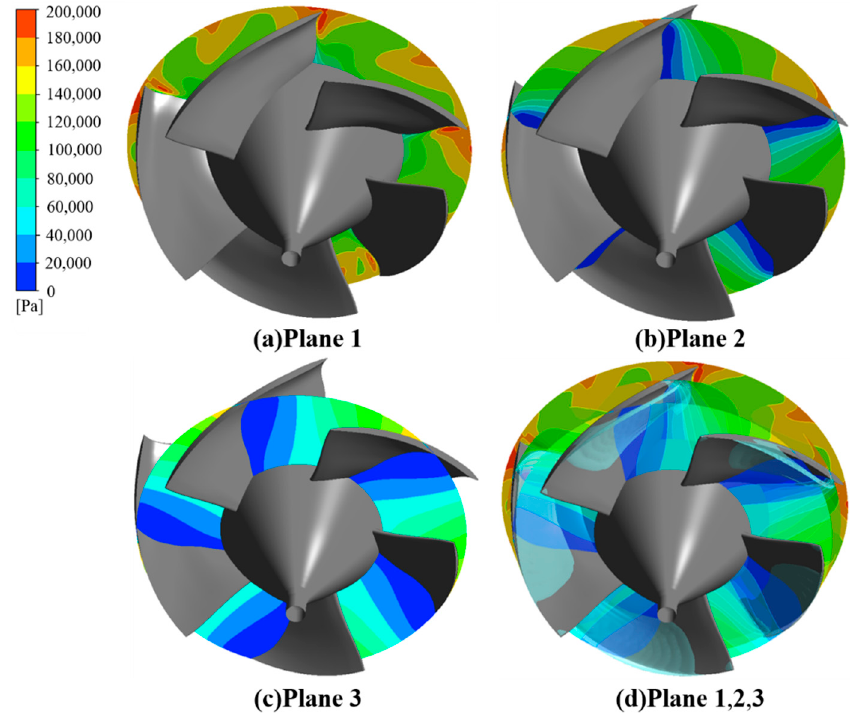
Figure 19. Contours of the pressure on different planes under the Breakdown Cavitation Condition.